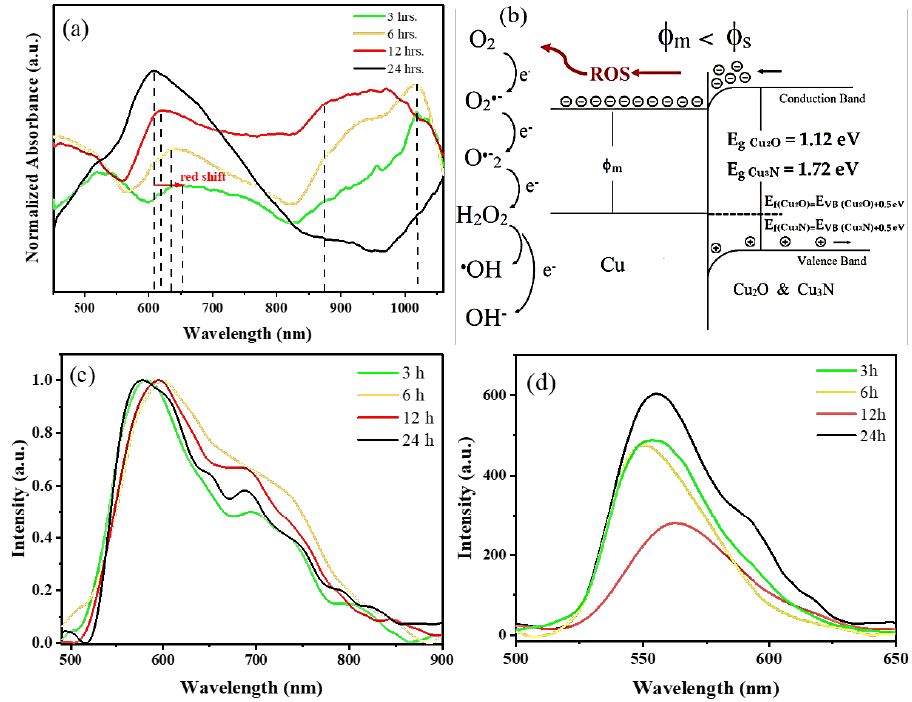
Figure 5. ( a ) Normalized UV-Vis absorption spectra of the nanoparticle mixtures, ( b ) downward band bending in p-type semiconductors, along with electron accumulation and transfer to the oxygen molecules generating ROS. The bandgaps of Cu 3 N and Cu 2 O were determined using the Tauc plots in Figure S4. Their band edges were then determined using the energy levels in references [49,50] . Photoluminescence emission spectra of the samples with an excitation wavelength of ( c ) 365 nm (normalized emission) and ( d ) 533 nm. In the photoluminescence spectra shown in Figure 5c,d, the emission is dominated by the Cu plasmonic emission for all the samples irrespective of the presence of other phases. PL emissions corresponding to Cu 3 N and Cu 2 O were once again not observed. For the Cu-24 sample, the pure Cu metal nanoparticles exhibit a strong emission peak at 554 nm, very close to the photoluminescence band of bulk cooper (560 nm) [46]. Nevertheless, a decrease in the emission intensity along with energy shifts are also notable in the spectra, influenced by the presence of secondary phases and differences in nanoparticle sizes. Ac- cording to the literature, the blueshift in the photoluminescence spectrum of the Cu-based nanoparticles is indicative of the presence of surface traps, while a redshift towards the band edge emission indicates defect-free nanoparticles [14]. The changes in the emission peak positions and intensities can be attributed to electron transfer mechanisms between various phases and changes in radiative recombination influenced by the ambient as well as semiconductor band bending. In fact, band bending is a phenomenon that occurs at the interface of a semiconductor and a metal. The nature of the band bending depends on the work functions of the two materials. In our case, the work function of Cu (4 eV) is lower than the work functions of Cu 3 N (5.06 eV) and Cu 2 O (5 eV) [51,52]. Therefore, a downward band bending in the p-type Cu 2 O and Cu 3 N occurs due to the formation of a Schottky